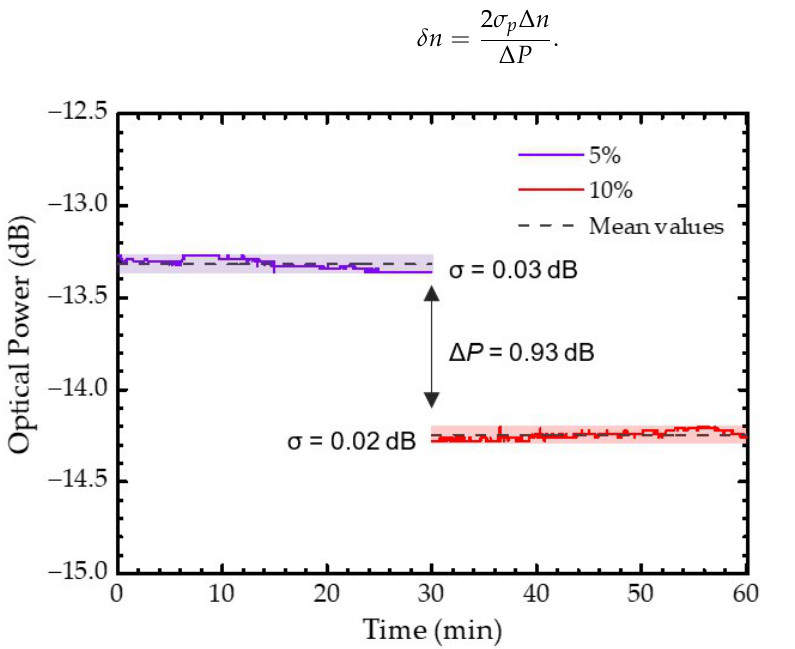
Figure 6. Optical power stability over a period of 60 min for 5 wt.% and 10 wt.% of glucose solutions. The shadowed zones represent the standard deviation ( σ ) of each